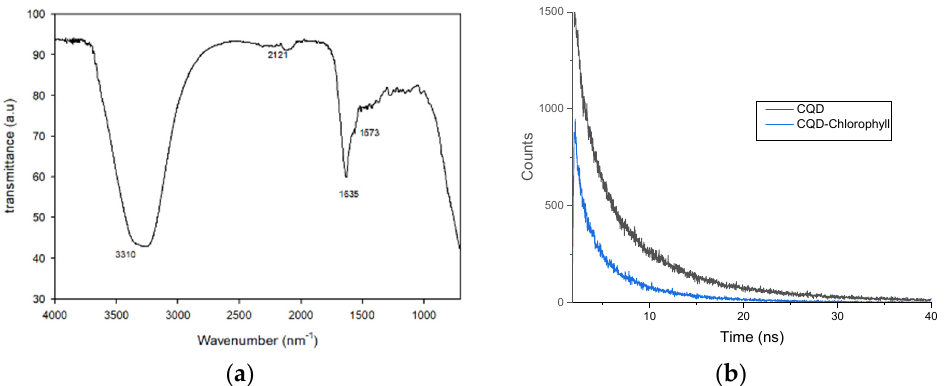
Figure 4. ( a ) Infrared spectra of a bare CQD. ( b ) Decay curve of a CQD and a CQD-chlorophyll. XPS measurements were carried out to investigate the details of CQD composition.